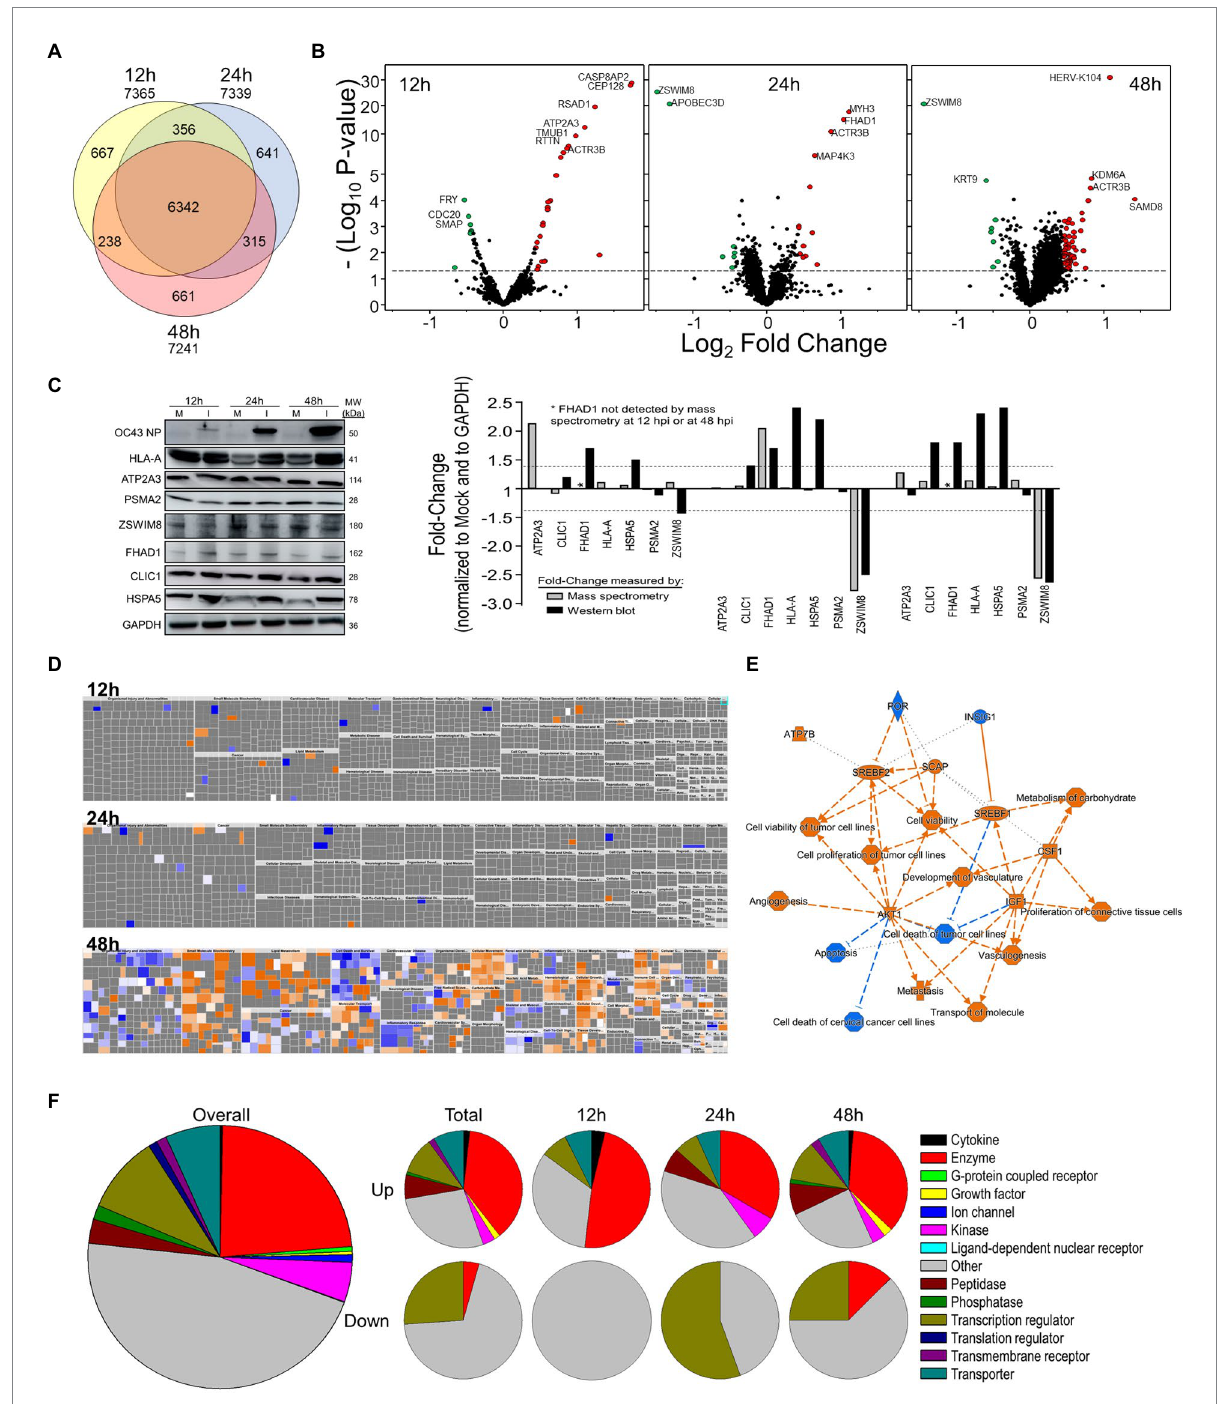
FIGURE 1 Tandem mass tag (TMT)-Mass spectrometry characterization of OC43-infected MRC-5 cells. (A) Venn diagram of numbers of proteins identified at each time point. (B) Volcano plots of dysregulated proteins. Horizontal dashed line indicates value of p of 0.05. (C) Western blot validation of protein dysregulation levels. The horizontal dashed lines represent ±1.4-fold-change cutoffs corresponding to Table 2. (D) Ingenuity Pathway Analysis (IPA)-predicted overall diseases and functions at each time point. (E) Major affected functions at 48 hours post-infection (hpi). (F) Gene ontologies of up- and downregulated